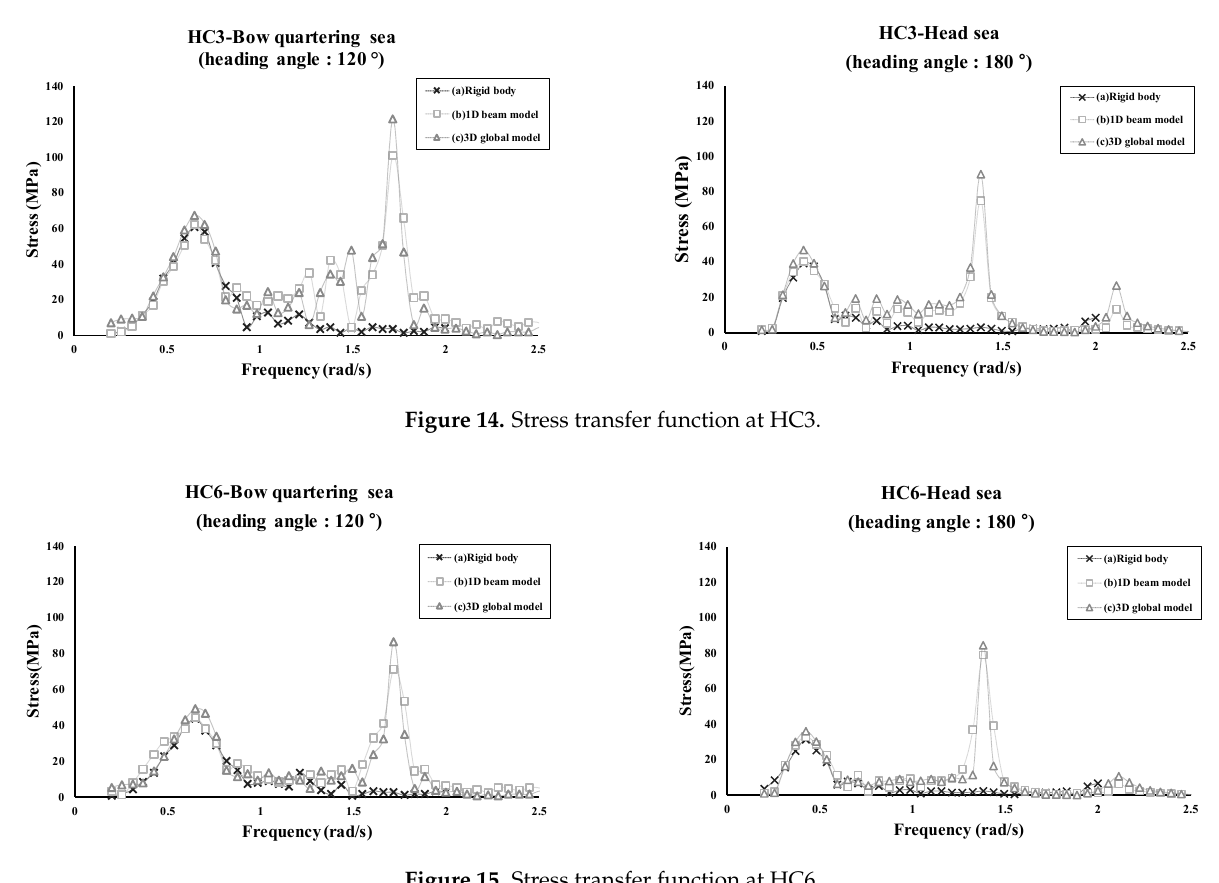
Figure 15. Stress transfer function at HC6.